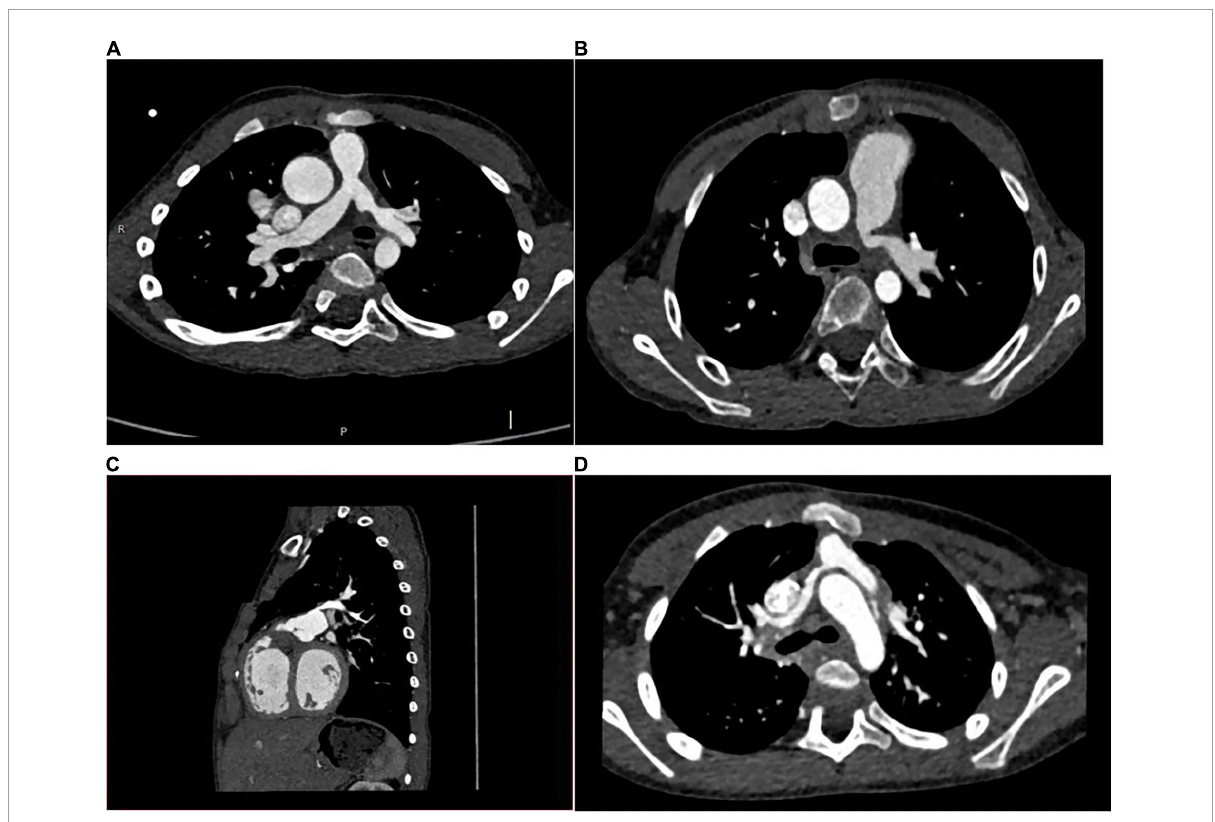
FIGURE3 MDCT images of cases. (A) : case 1 had PA/VSD, LPS; (B) : case 8 had TOF, LPS; (C) : case 3 had VSD, LPS; (D) : case 5 had TGA, RPS.